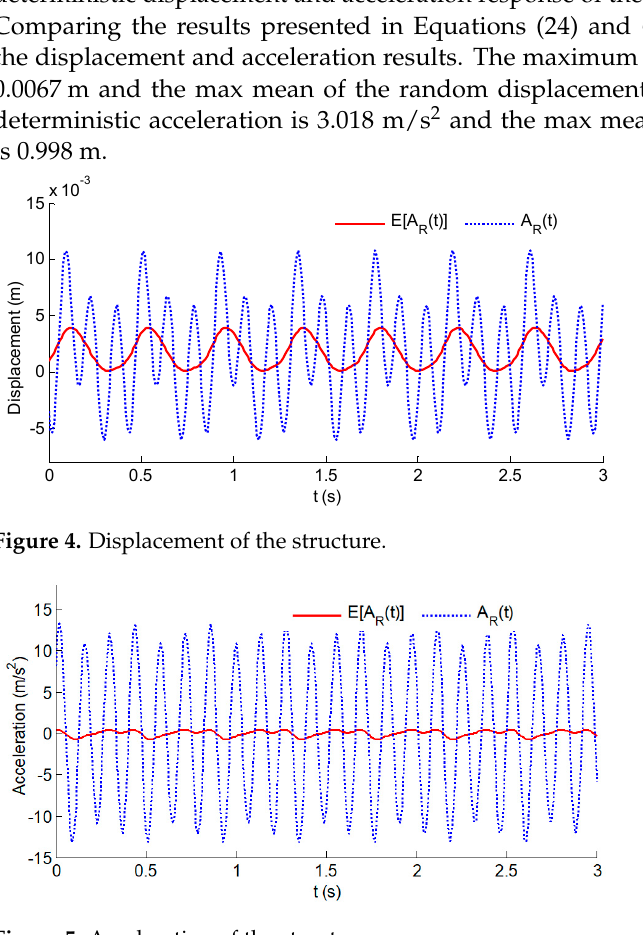
Figure 5. Acceleration of the structure. If the values of δ